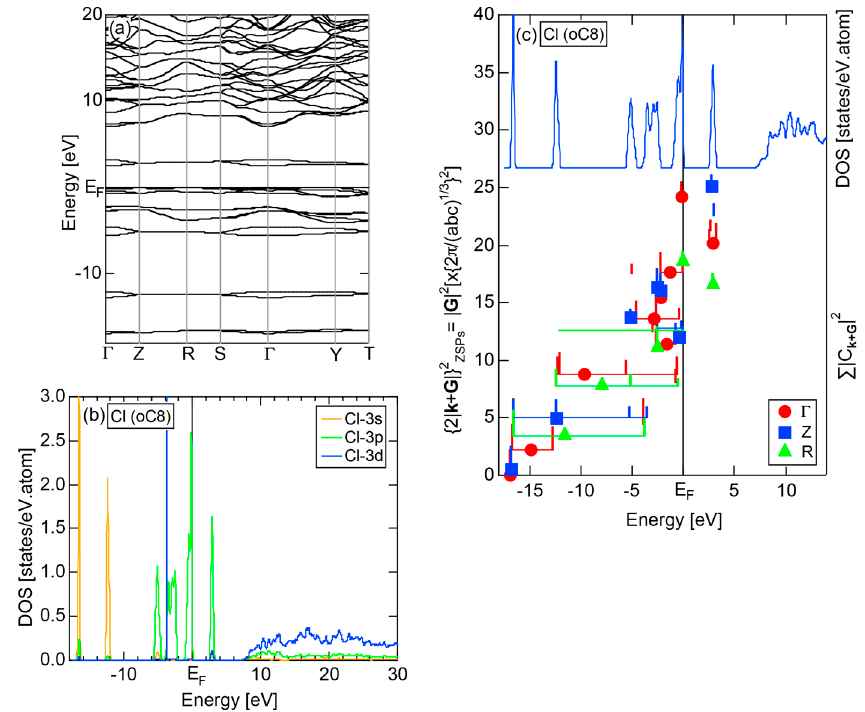
Figure 14. ( a ) Dispersion relations; ( b ) partial DOSs and ( c ) FLAPW-Fourier spectra at symmetry points Γ , Z and R of the Brillouin zone for the base-centered orthorhombic lattice for insulating solid Cl (oC8) [11]. The total-DOS is incorporated in ( c